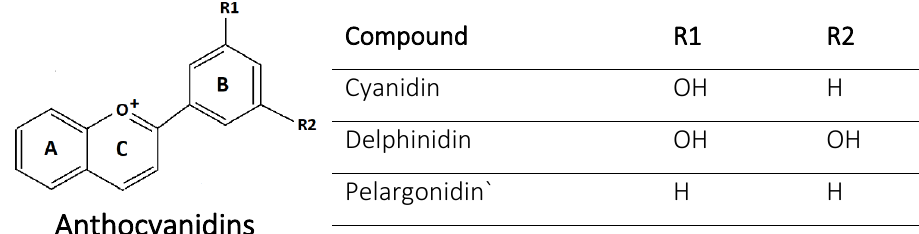
Figure 6. Anthocyanidins: chemical structures, types and substitution positions in the basic skeleton.